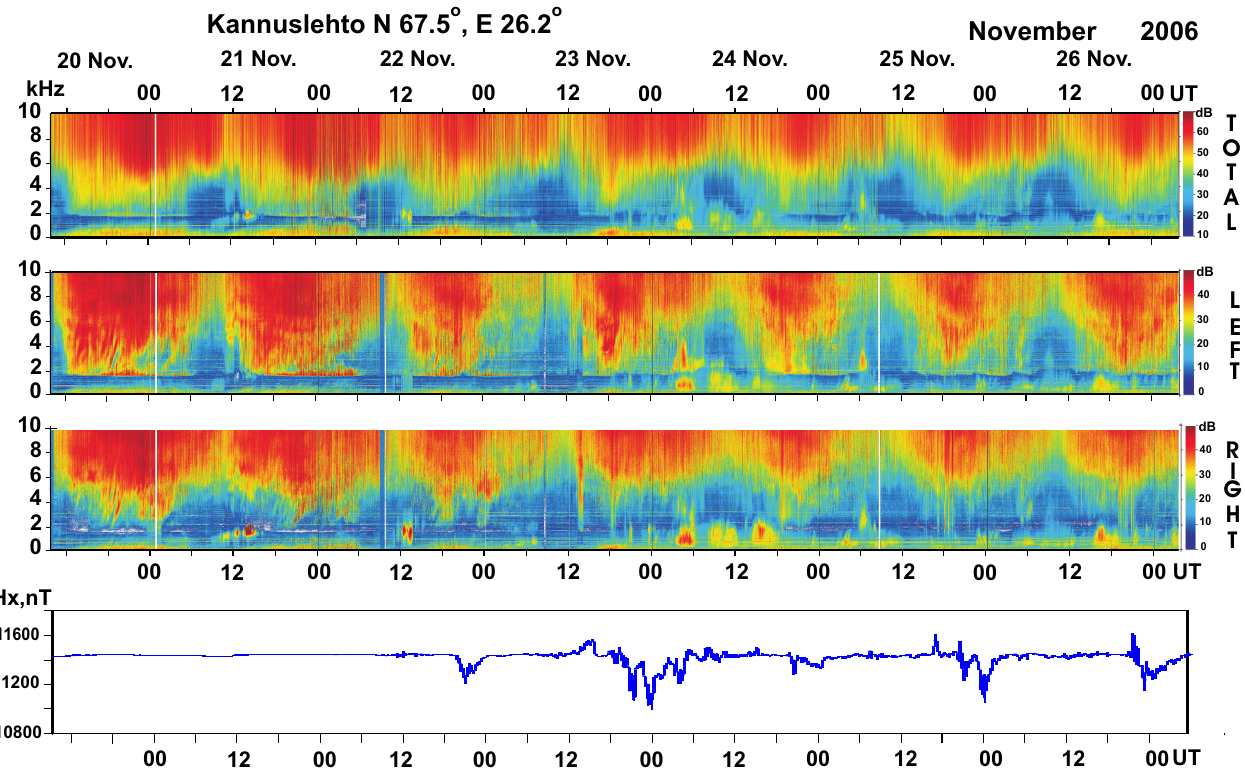
Fig. 1. Sample spectrograms of ELF-VLF waves recorded during the 20–26 November 2006 campaign in the auroral zone. The upper panel shows the spectrogram of the total power, the second panel represents the dynamic spectrum of the LHP, the third panel depicts the RHP dynamic power spectrum and the bottom plot shows variations of the H x component of the geomagnetic field at the Sodankula observatory. A narrow band maximum is clearly seen around the first critical frequency of the Earth-ionosphere duct or at the first transverse resonance frequency: around